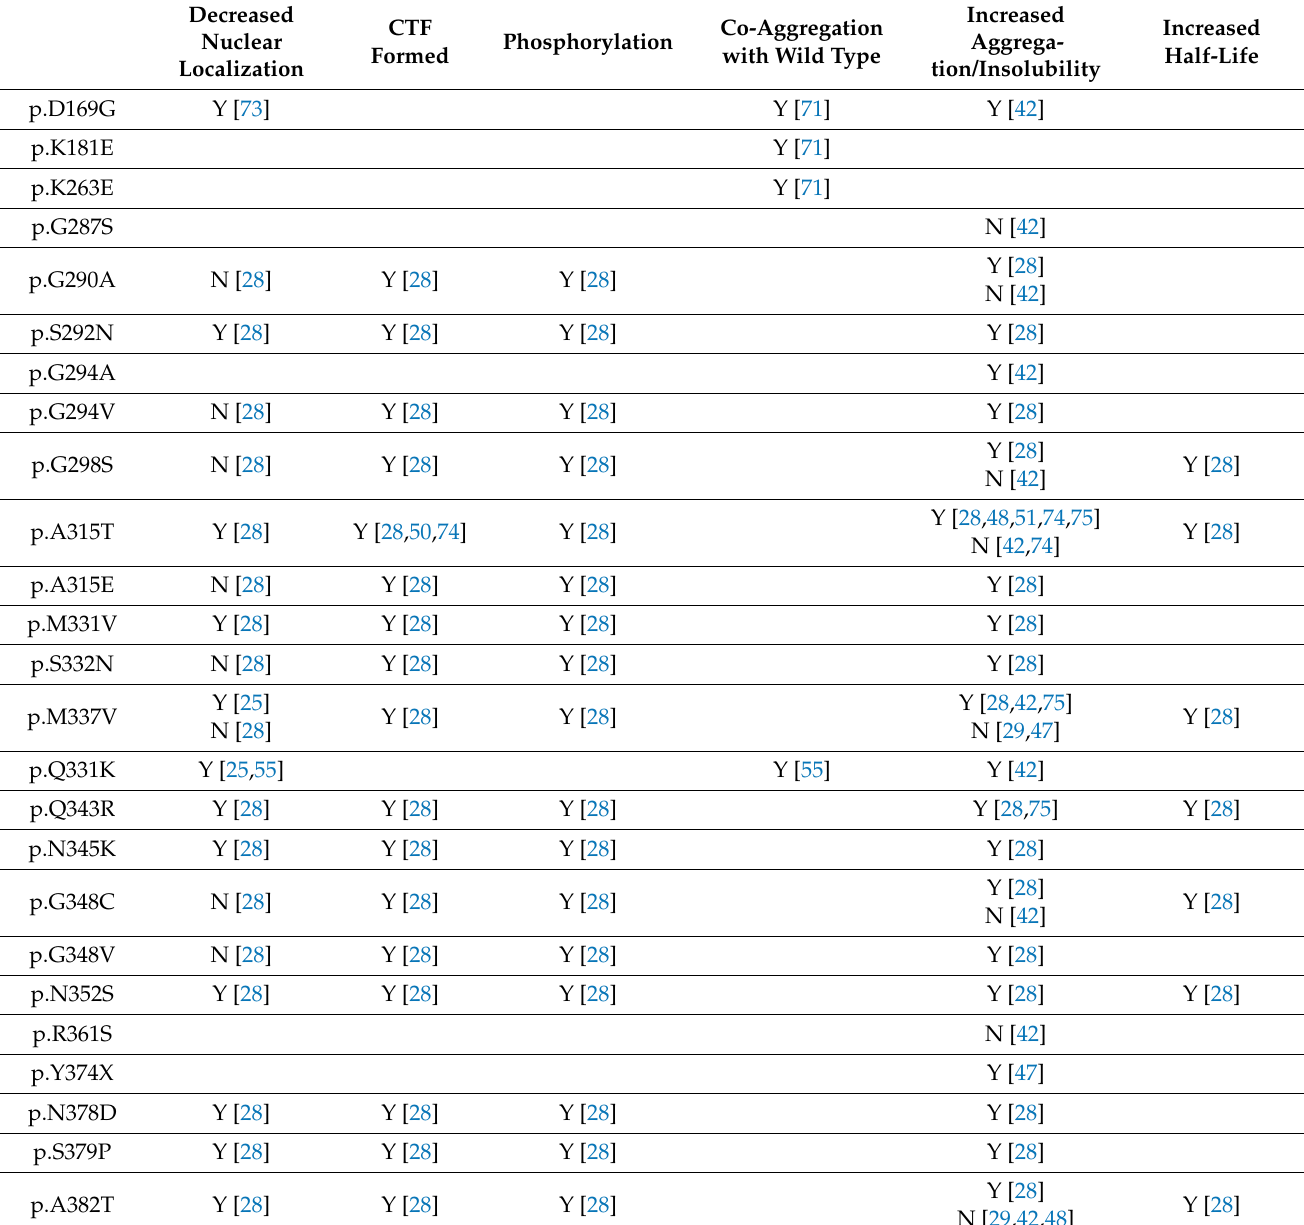
Table 1. Characteristics of mutant TDP-43 proteins and C-terminal